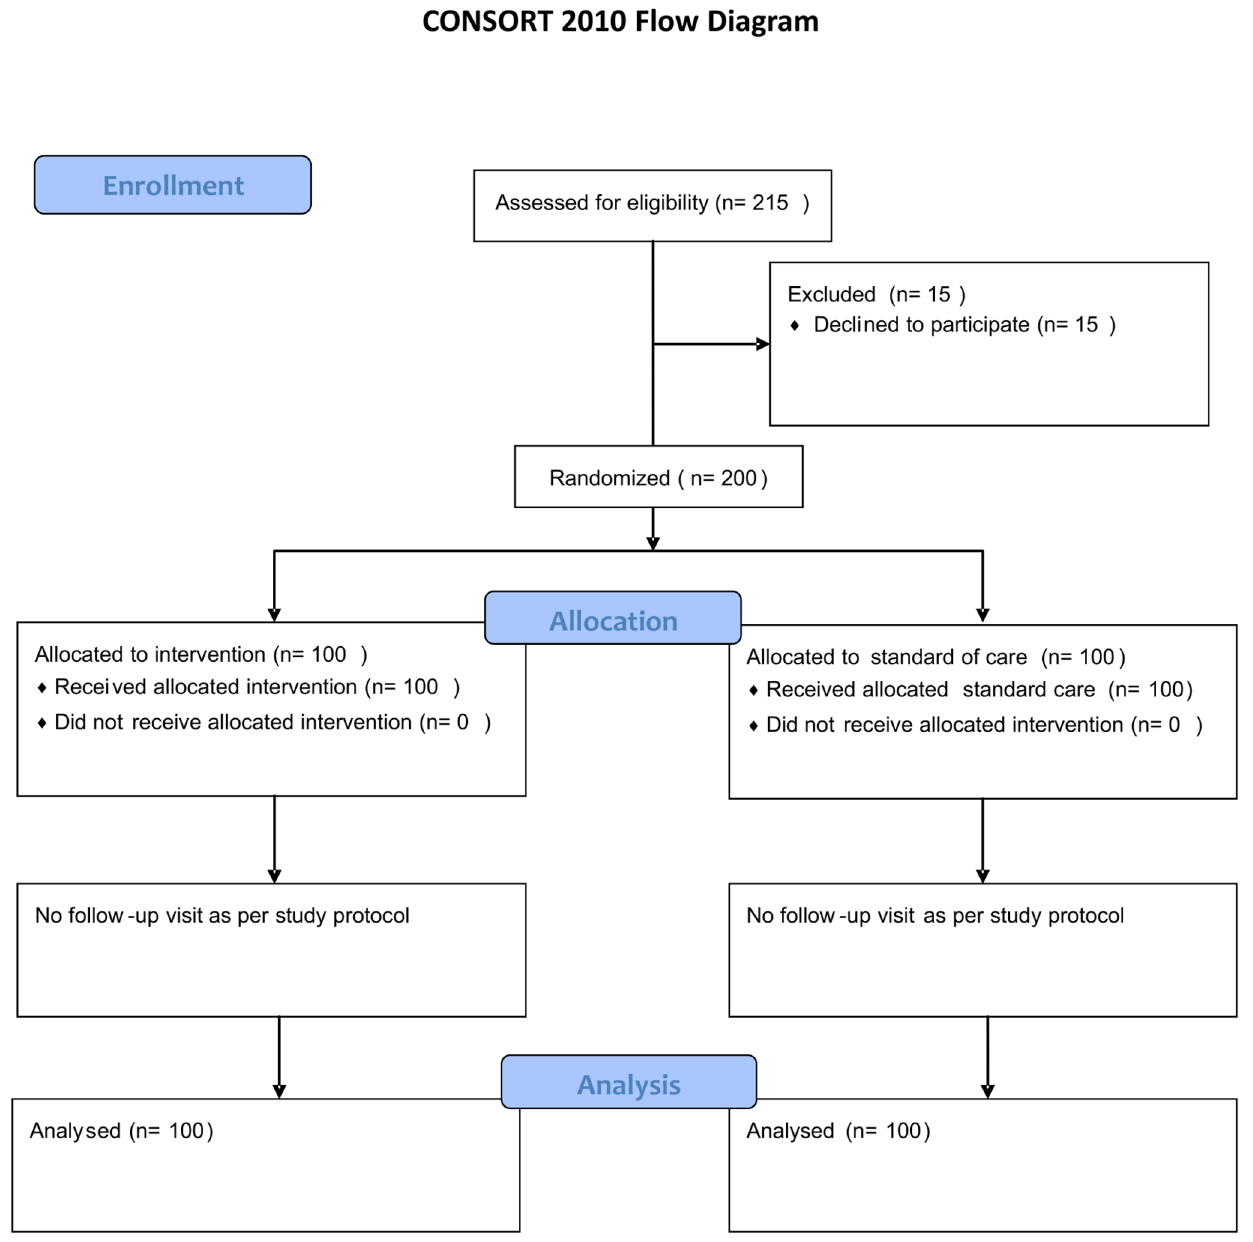
Fig 1. CONSORT flow